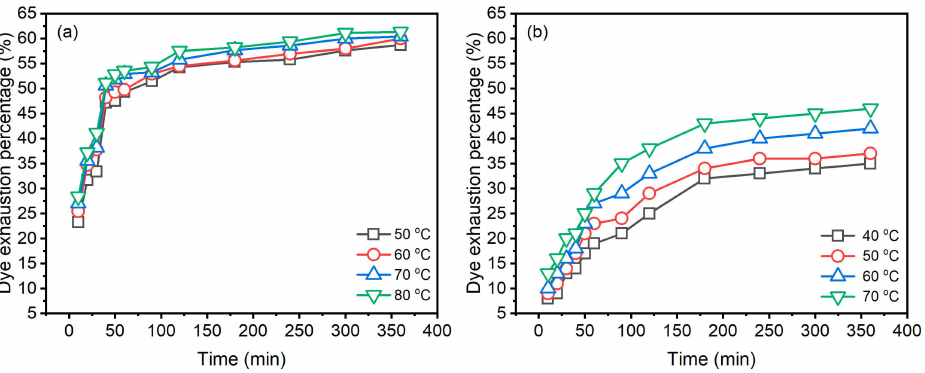
Figure 4. Dye exhaustion of Reactive Blue 194 in the dyeing of raw ramie yarn in ( a ) palm oil medium and ( b ) water